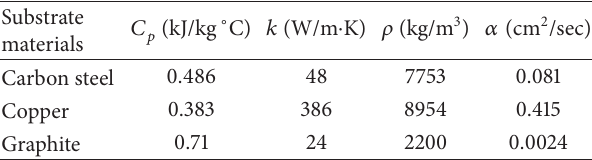
Table 3: Thermophysical properties of the substrates used [7, 8]. Substrate